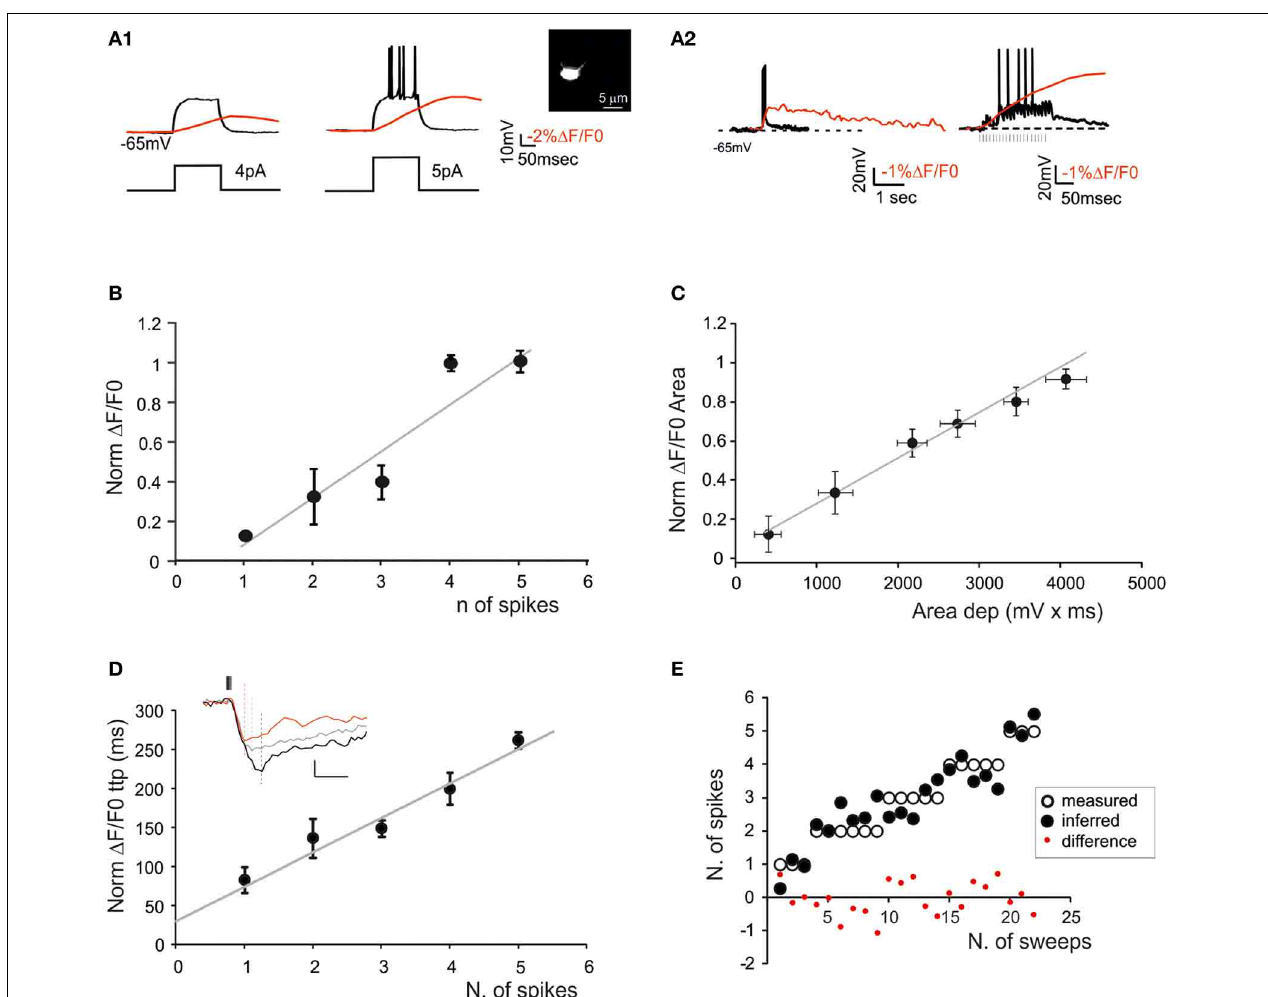
p < 0 . 05; mean ± s.e.m.). (C) Dependence of normalized (cid:3) F/F 0 area on the average depolarization in response to mossy fiber bursts (20 stimuli at 100Hz) revealing a linear correlation (gray line n = 5 cells; R 2 = 0 . 98; p < 0 . 001; mean ± s.e.m.). Only sub-threshold responses were considered. (D) Dependence of normalized (cid:3) F/F 0 time-to-peak on the number of spikes emitted in response to mossy fiber bursts (20 stimuli at 100Hz) revealing a linear correlation (gray line; n = 5 cells; R 2 = 0 . 94; p < 0 . 01; mean ± s.e.m.). The traces in the inset show (cid:3) F/F 0 signals correlated with 1 (red), 3 (gray), and 5 spikes (black) (E) Comparison of the number of spikes measured in GrCs and that predicted by the slope of the time-to-peak vs. spike relationship shown in (D) . Note the matching between predicted and measured results (two-tailed t -test; p = 0 . 82).